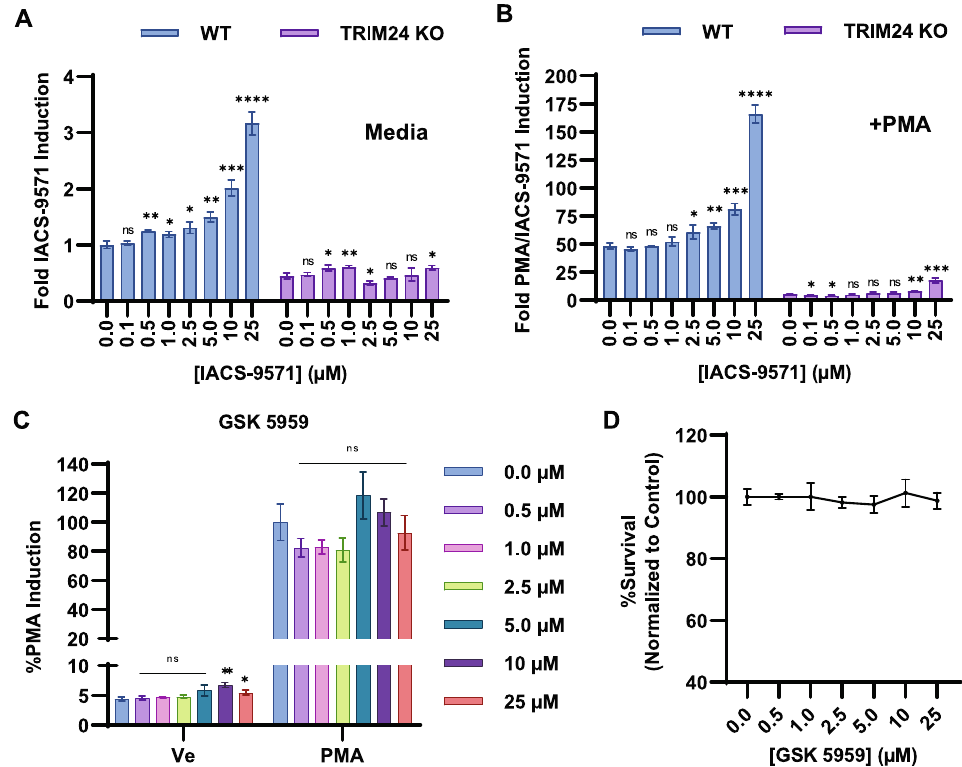
Figure 4. IACS-9571 requires TRIM24 for induction of HIV-1 expression. ( A ) Wildtype and TRIM24 KO mHIV-Luciferase cells were treated with the indicated concentration of IACS-9571 for 4 h prior to luciferase assay. Assays were performed in triplicate, with error bars representing standard deviation. ( B ) Same as ( A ), but cells were co-treated with 20 nM PMA. Shown are the results of triplicate measurements, error bars represent standard deviation. ( C ) Jurkat mHIV-Luciferase cells were treated with the indicated concentration of GSK-5959 in the presence or absence of 20 nM PMA. Following 4 h ncubation, luciferase assay was performed. Shown are the results of three measurements, with error bars representing standard deviation. ( D ) Viability of mHIV- Luciferase cells were measured following 4 h incubation with the indicated concentration of GSK-5959. Assays were performed in duplicate with standard deviations displayed as error